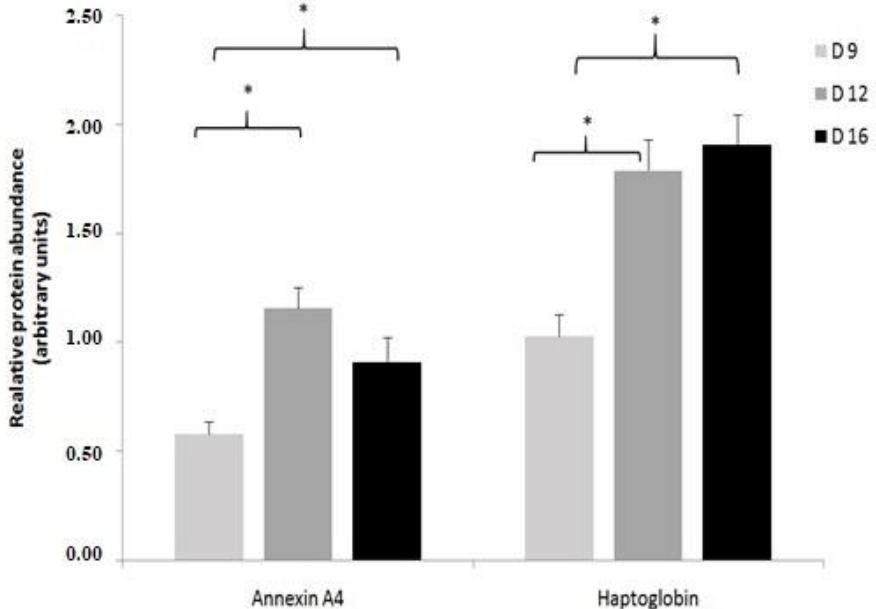
Figure 9. The statistical summary of the protein abundance analysis of four biological repeats relative to the loading control (GAPDH). Data are presented as mean ± SEM, * p ≤ 0.05; Wilcoxon test. (For more details: Supplementary Table S2).